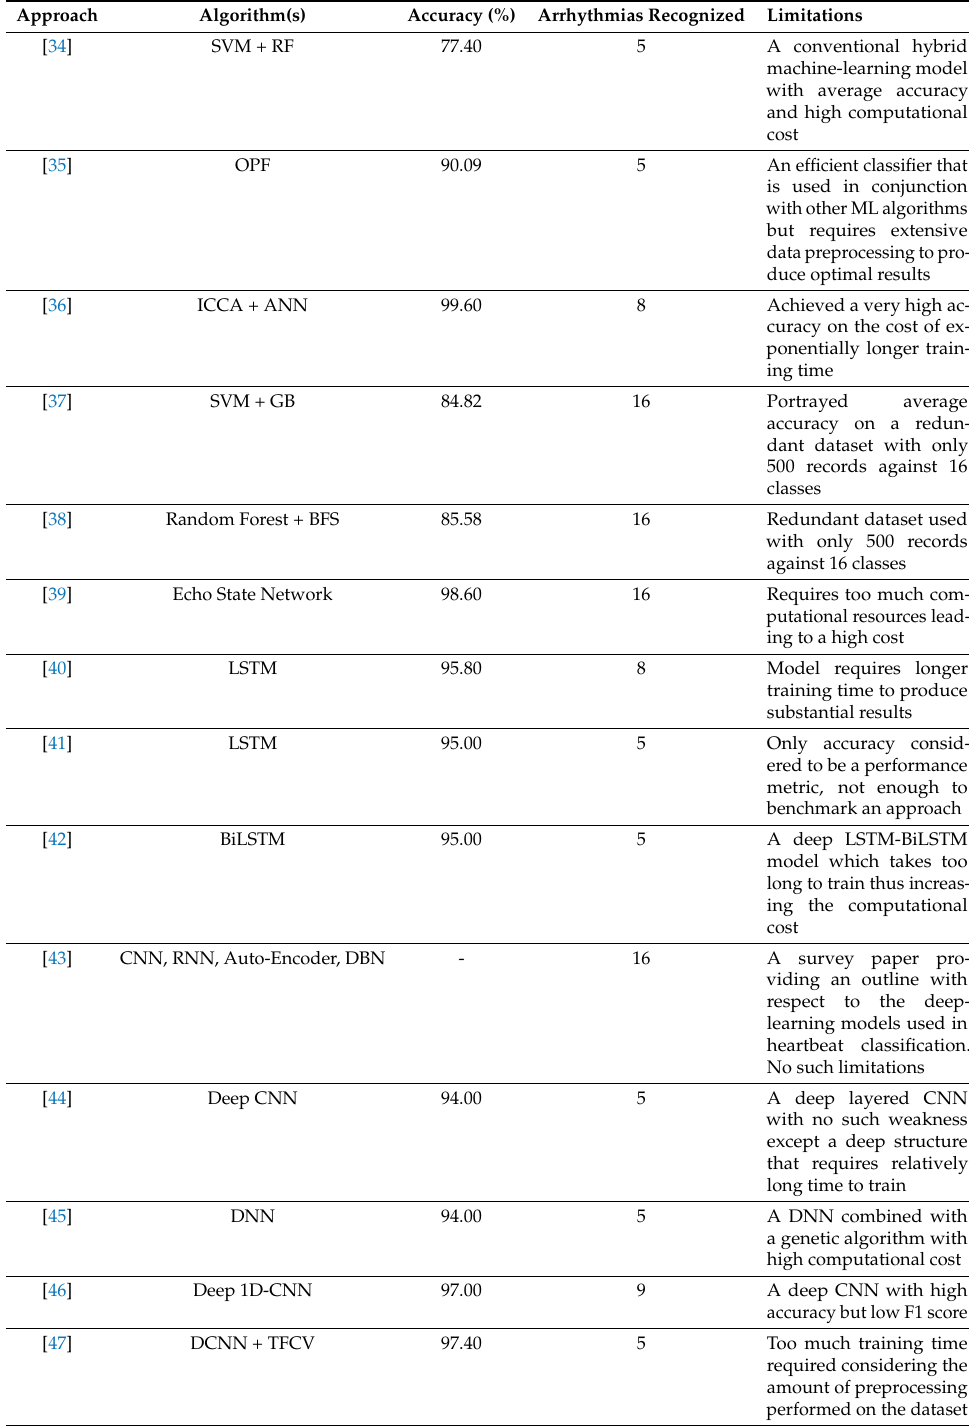
Table 1. Literature